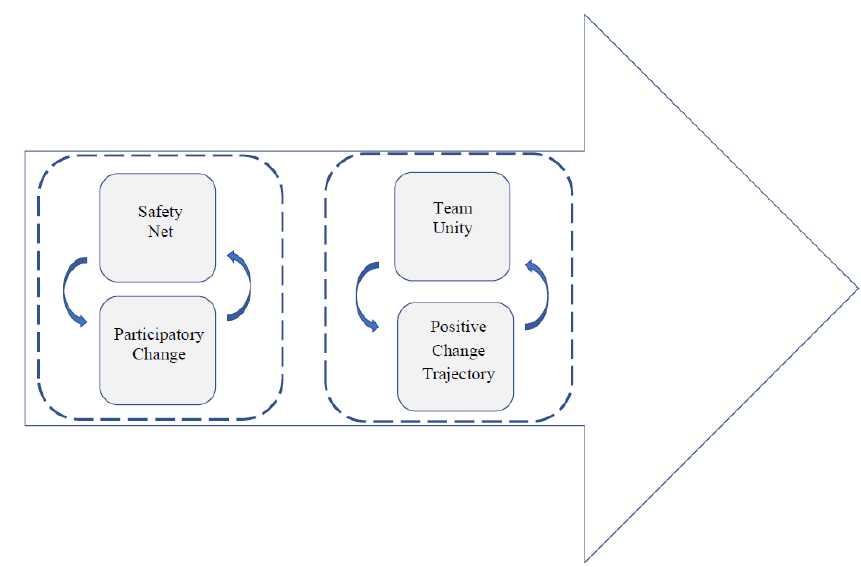
Figure 3. Process model of the dynamic mechanisms of change.